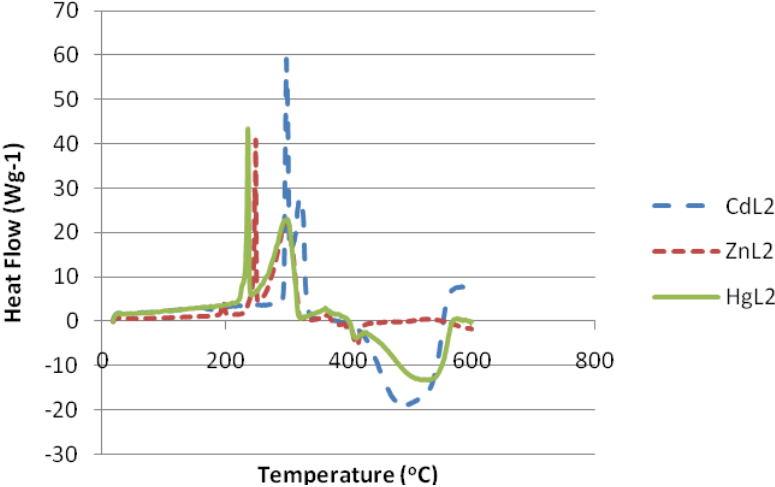
Figure 2. DSC curves of the complexes (in nitrogen) at a heating rate of 5 °C min −1 .